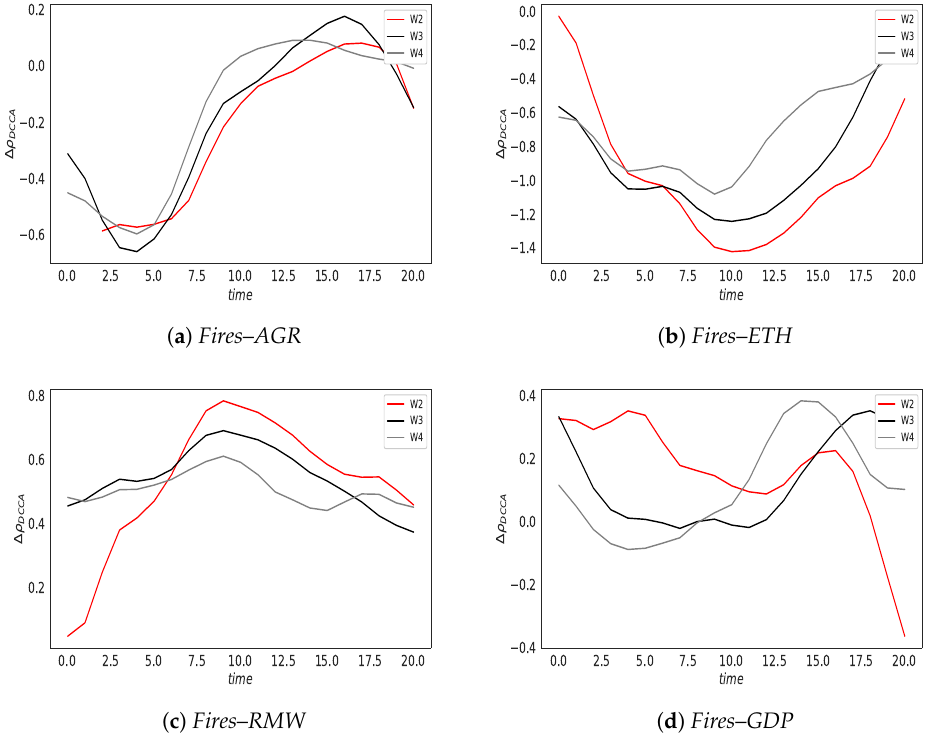
Figure A5. The ∆ ρ dcca for the different TS pairs and time scale n =